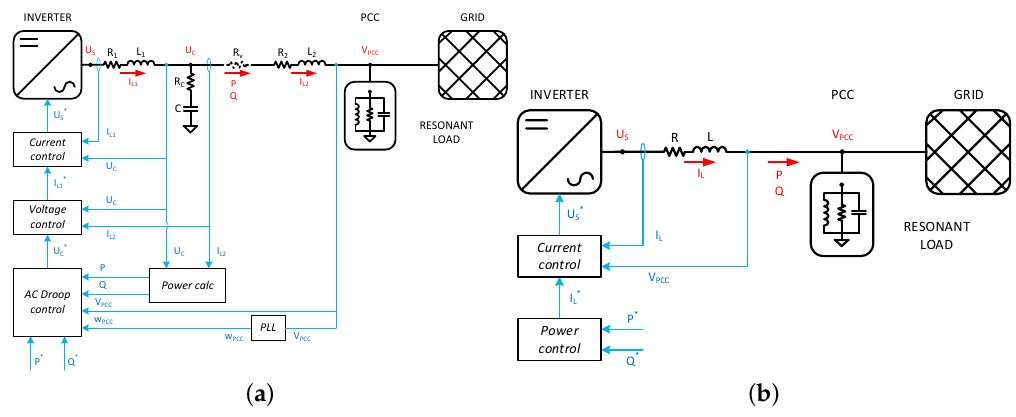
Figure 1. Control topology in grid-connected mode with a resonant local load. ( a ) Voltage-controlled voltage source inverter (VC-VSI) topology. ( b ) Current-controlled voltage source inverter (CC-VSI) topology. PCC, point of common coupling; PLL, phase locked